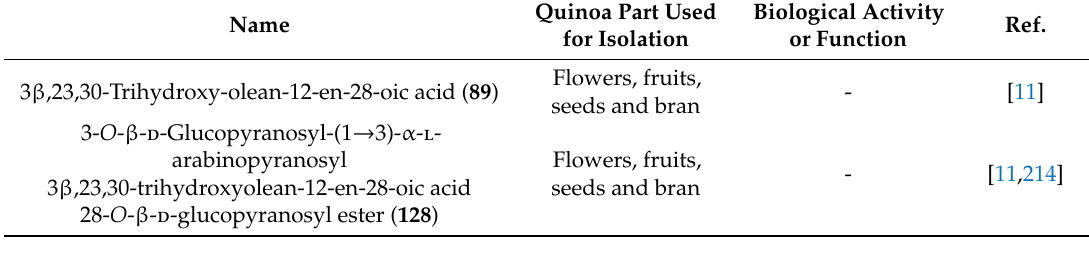
Table 16. 3 β ,23,30-Trihydroxy-olean-12-en-28-oic acid triterpenoids and their biological activities or functions.